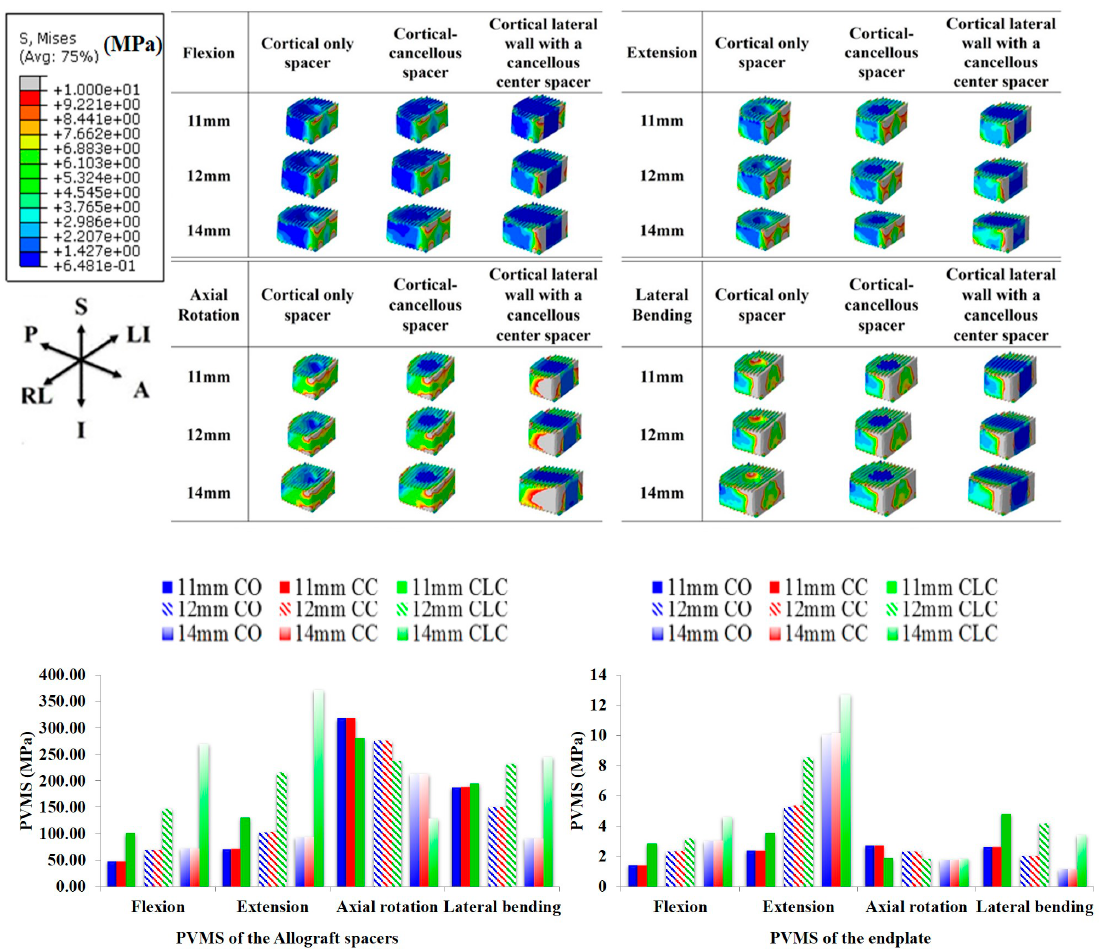
Figure 4. Peak von Mises stress (PVMS) on the allograft spacers and endplates under hybrid motion. Table 1. Peak stress levels of motion in the motion model.